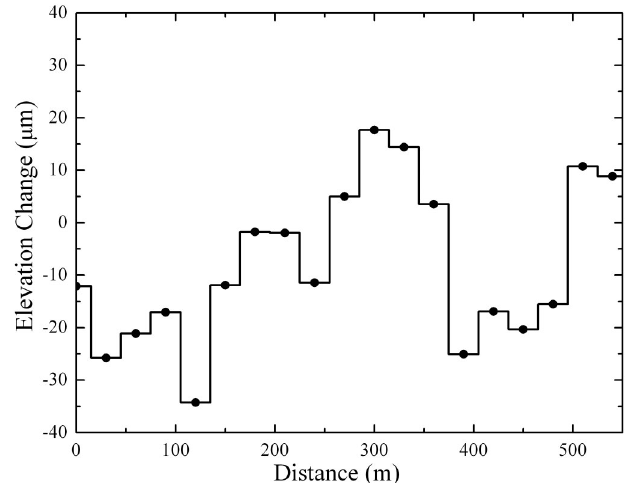
FIG. 35. (Color) HLS probe on Tevatron accelerator focusing